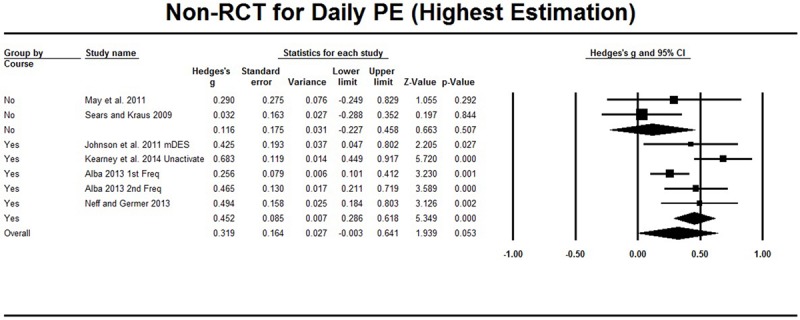
Non-RCT studies on daily PE. The highest estimation was based on frequency of happiness (Freq) in Alba (2013), unactivated positive emotion (Unactivate) in Kearney et al. (2014) and modified Differential Emotions Scale (mDES) in Johnson et al. (2011). Subgroup analysis compared LKM with course and without course.